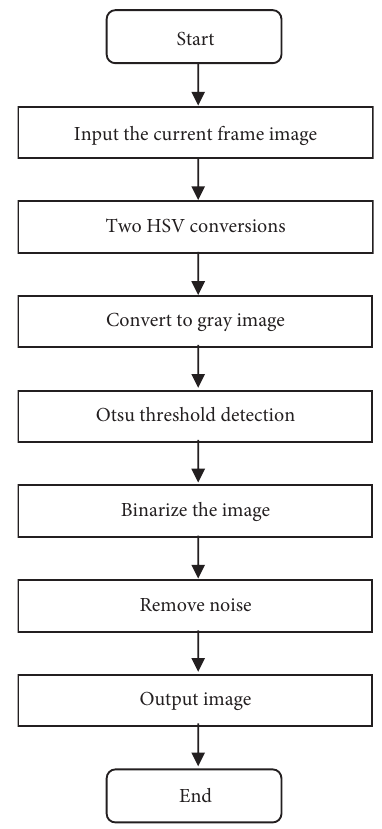
Figure 4: Flowchart of shadow area